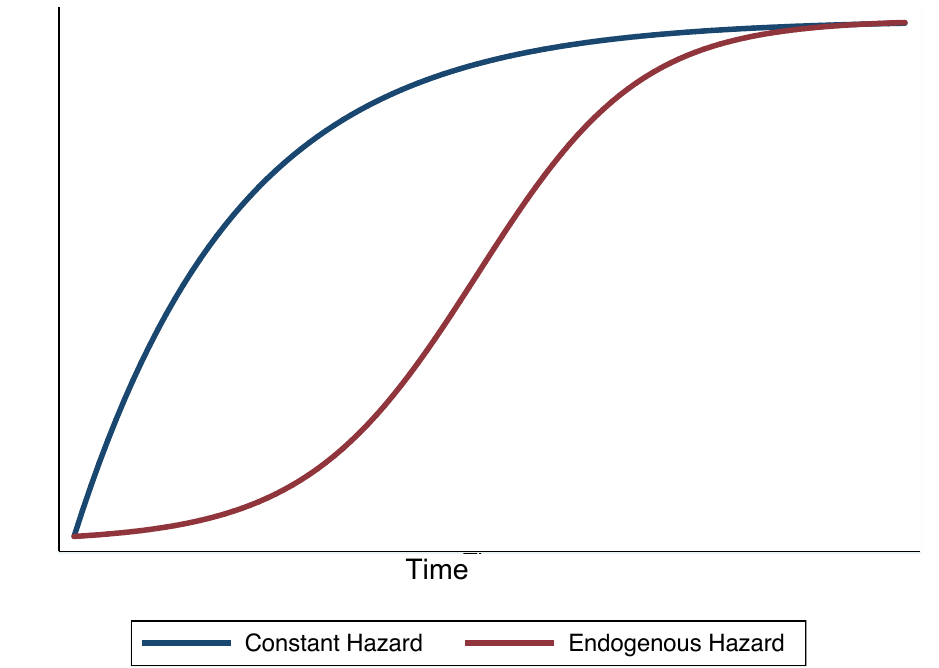
Figure 1: Ideal-typical innovation diffusion